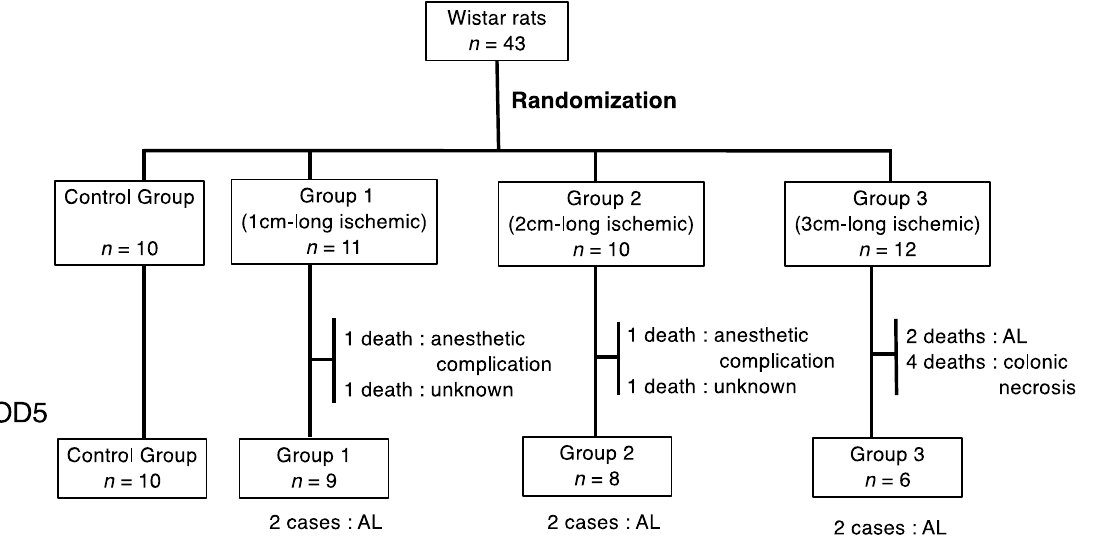
Figure 1. Study design and randomization of groups.